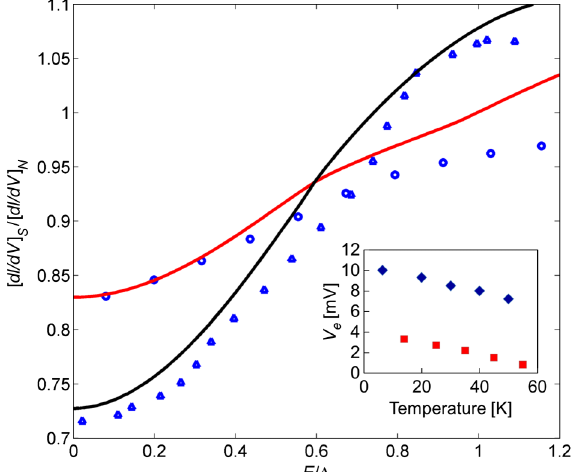
FIG. 4. AC differential conductance ½ dI=dV (cid:4) S at 14 K, divided by the normal-state conductance ½ dI=dV (cid:4) N for the Bi-2212/ GaAs junction measured (circles) and calculated (solid red) with the (cid:2) ¼ 15 meV , and for the Bi-2212/GaAs/AlGaAs junc- tion measured (triangles) and calculated (solid black) with the (cid:2) ¼ 6 meV . The inset is the excess voltage vs temperature in a bulk-GaAs device (red squares) and in the QW-based device (blue diamonds).